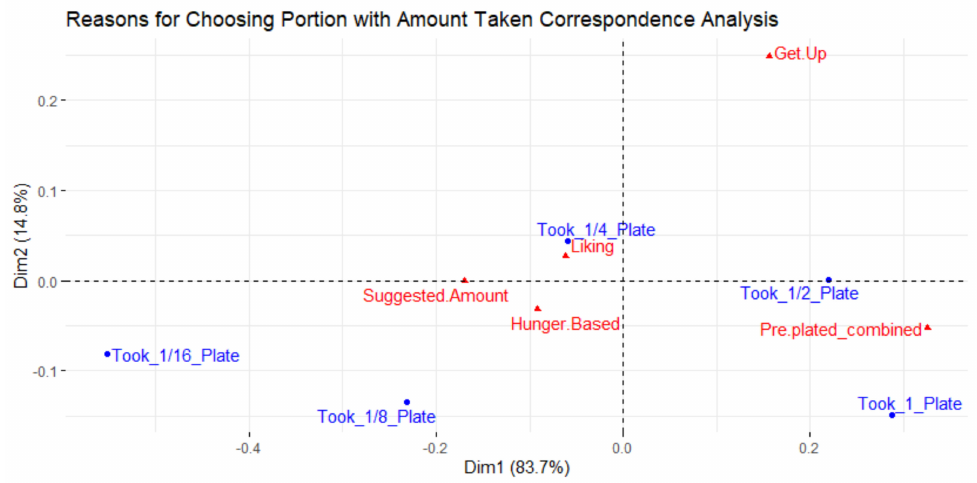
Figure 8. Correspondence analysis relating reasons why participants selected the amount of food and the amount of food taken.